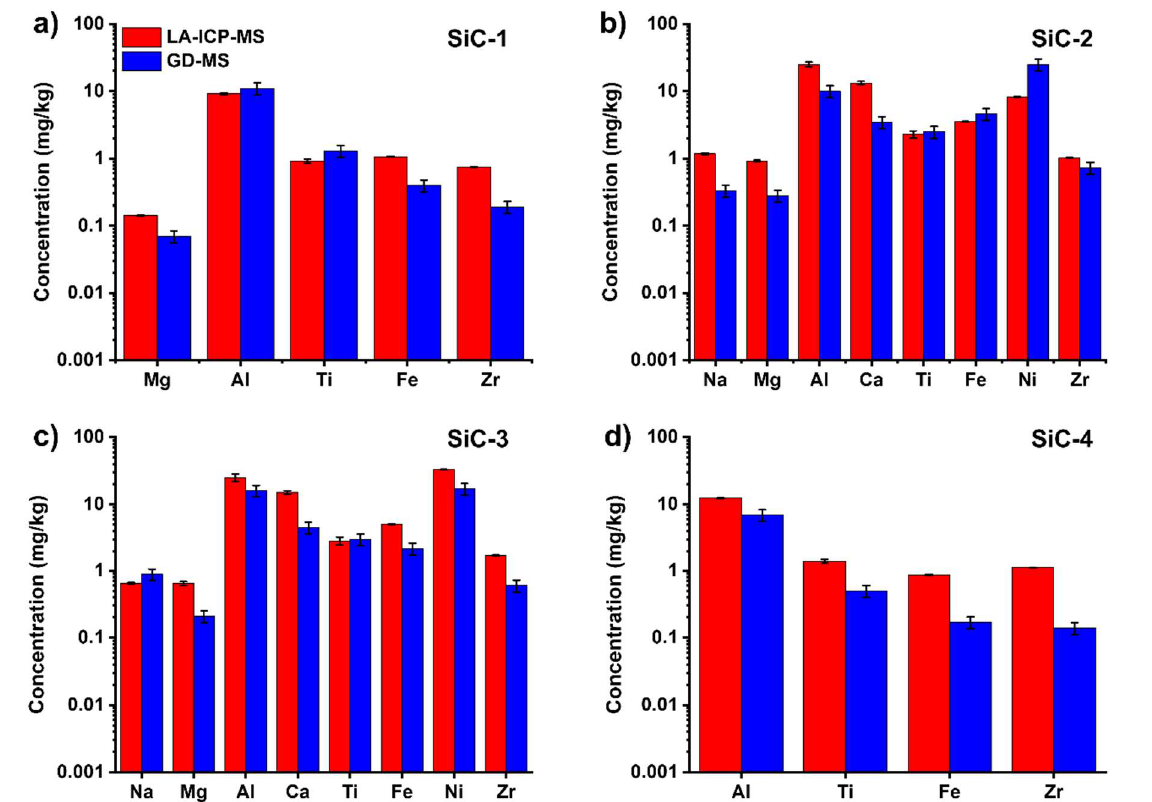
Figure 6. Concentration of selected trace elements in SiC samples as determined by LA-ICP-MS (red bars) and GD-MS (blue bars): ( a ) SiC-1, ( b ) SiC-2, ( c ) SiC-3 and ( d ) SiC-4. Elements not included in